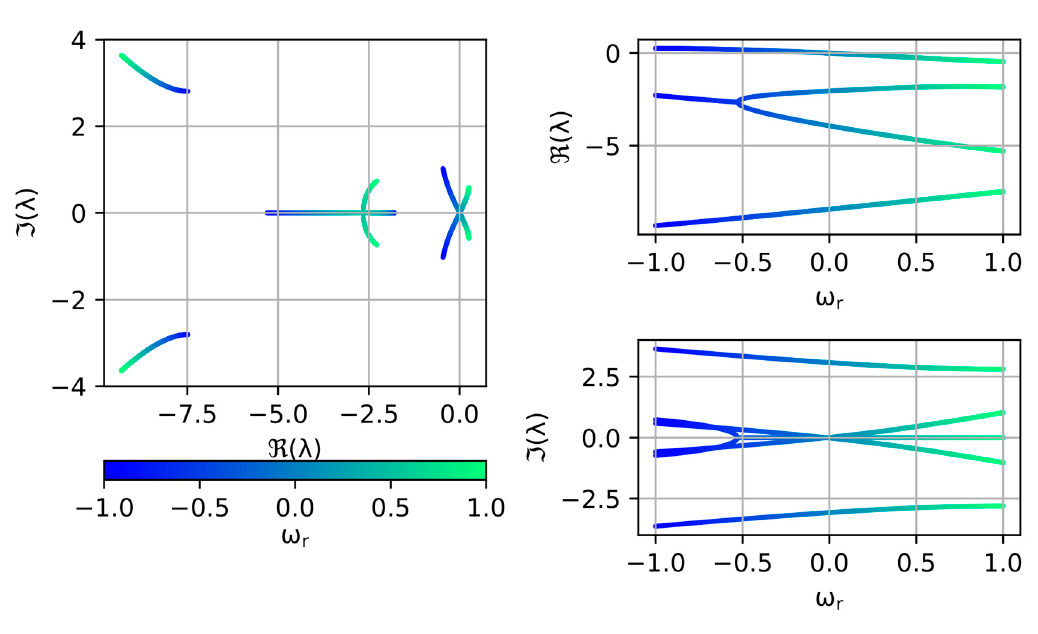
Figure 4. Poles placement of the observer in the function of the load torque under nominal rotor speed and nominal rotor flux.